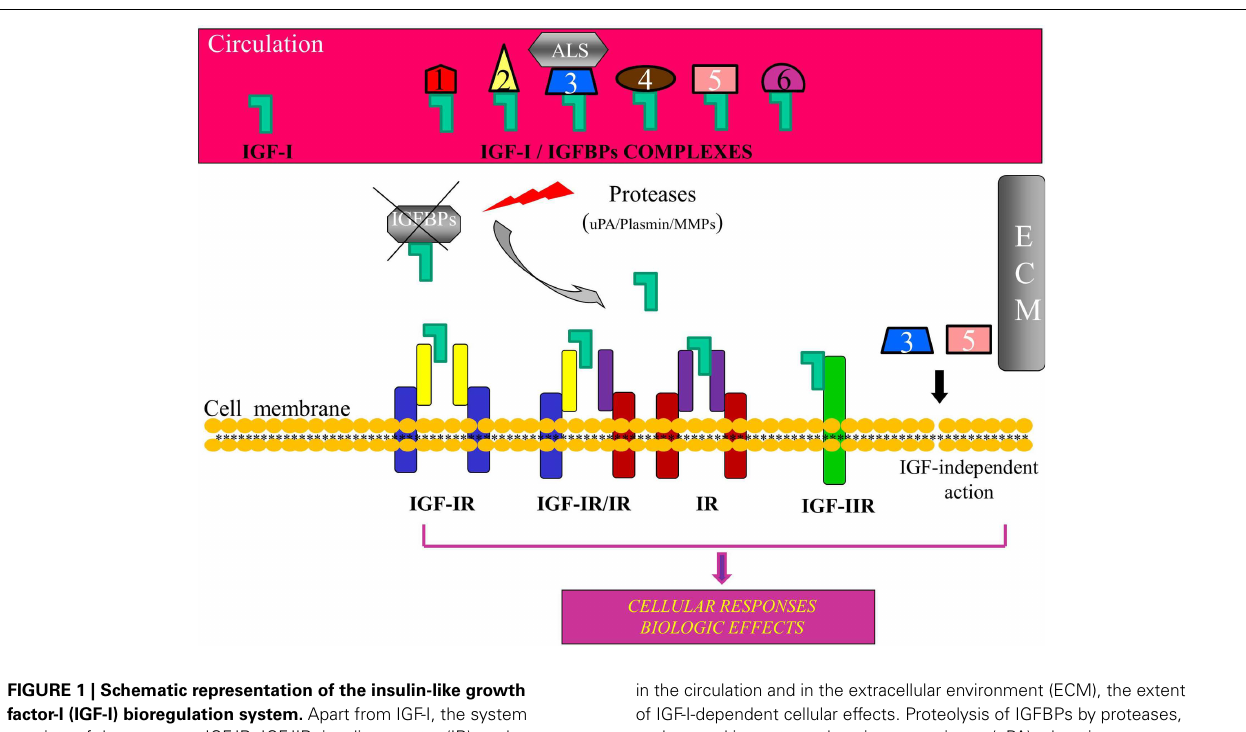
FIGURE 1 | Schematic representation of the insulin-like growth factor-I (IGF-I) bioregulation system. Apart from IGF-I, the system consists of the receptors IGF-IR, IGF-IIR, insulin receptor (IR), and IGF-IR, IR hybrids, and at least six high affinity insulin-like growth factor binding proteins (IGFBPs). IGF-I circulates mainly in an IGF/IGFBP-3/ALS complex. Binding of IGFBPs to IGF-I prevents the ligand to interact with the receptor(s) and IGFBPs can modulate, both